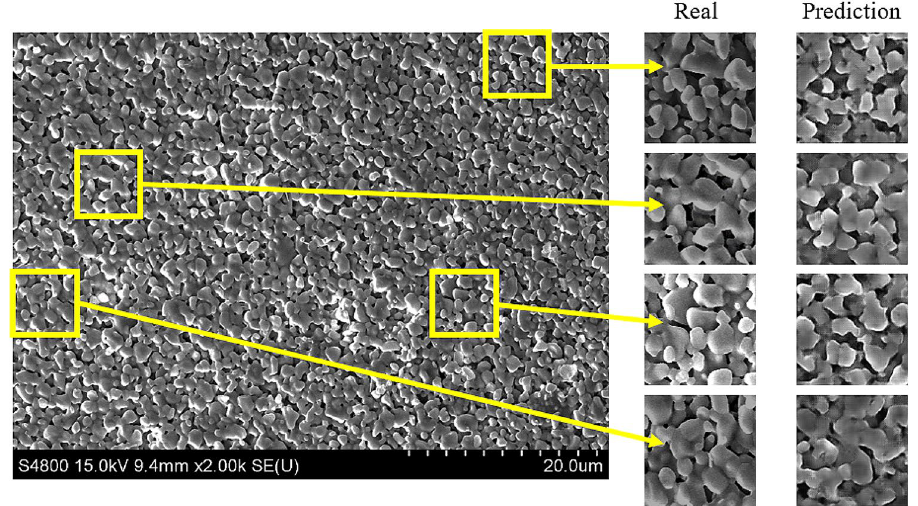
Figure 4. The large domain SEM image of an alumina sample sintered under 1.6 W, with small domain of SEM magnified from the large one and the corresponding predicted SEM images using the